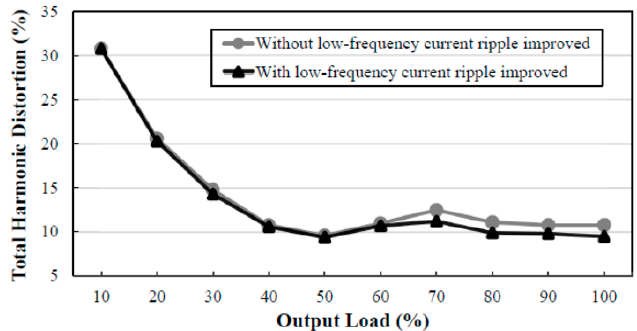
Figure 16. Curve of total harmonic distortion versus output load under 220 V input voltage.